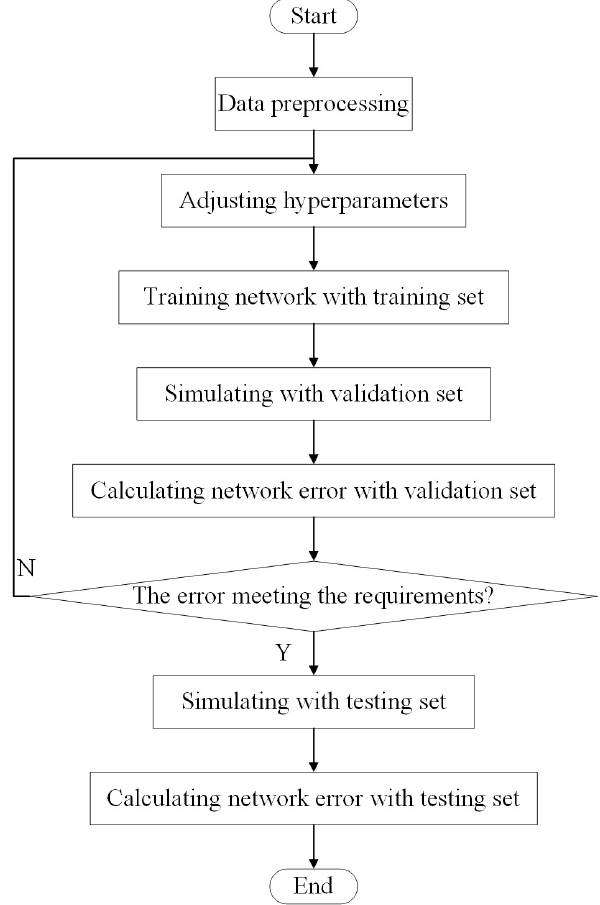
Figure 6. The flowchart of PV power forecasting.